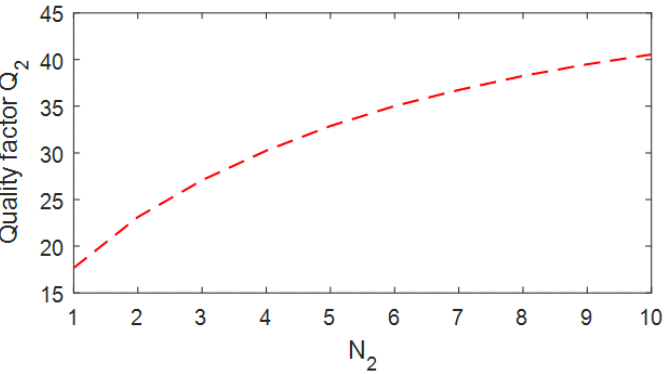
Figure 10. Quality factor Q 2 of the receiving coil versus N 2 , adopting fixed values of intraturn spacing s 2 = 1 mm, ferrite thickness t mag = 0.5 and coil thickness t c = 0.5 mm.